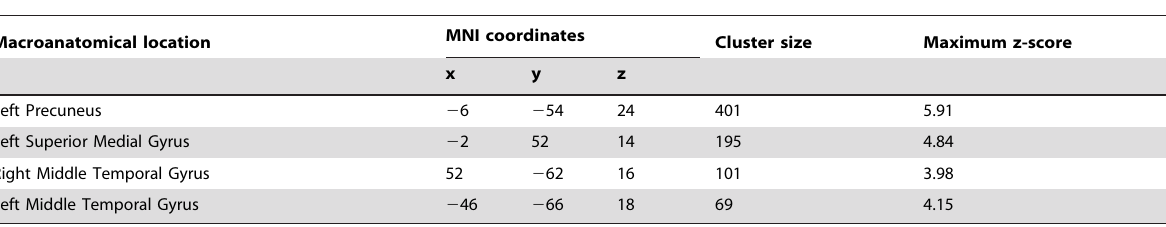
Table 5. Activation peaks of conjunction analysis of SOC > DMN.